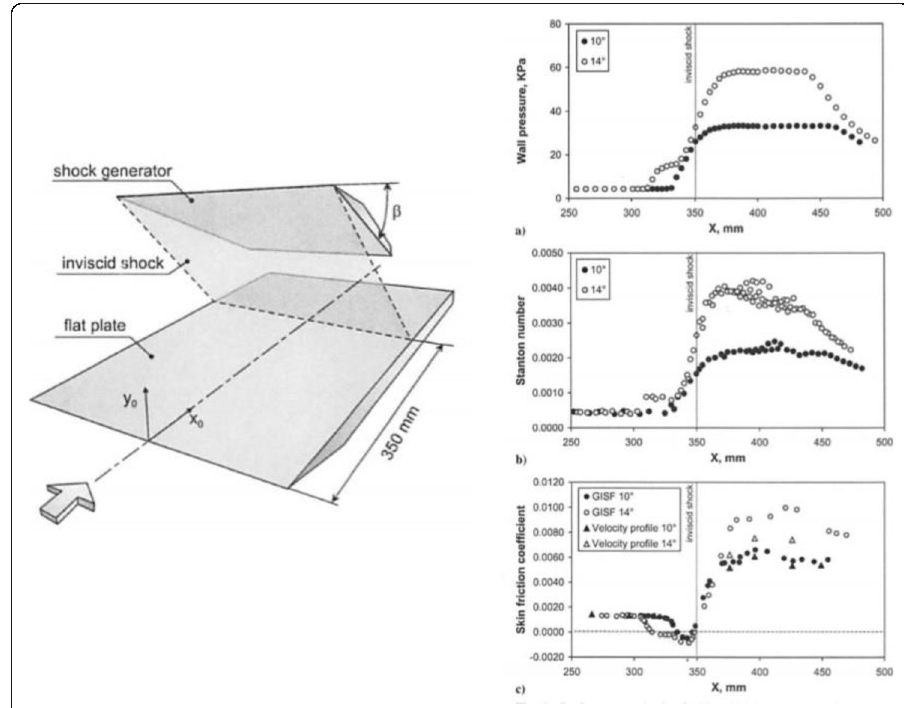
Fig. 4 a Arrangement used to create two-dimensional oblique shock waves. b Variations of local skin friction coefficients, local Stanton numbers, and wall static pressure values with streamwise development, as the flow approaches the near-wall location of the inviscid shock waves